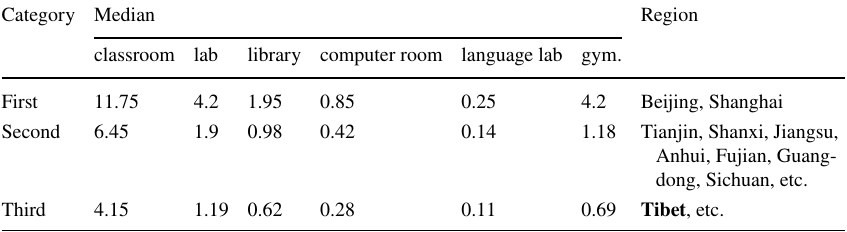
Table 8 Clustering of six indicators (senior high school) Category Median classroom lab